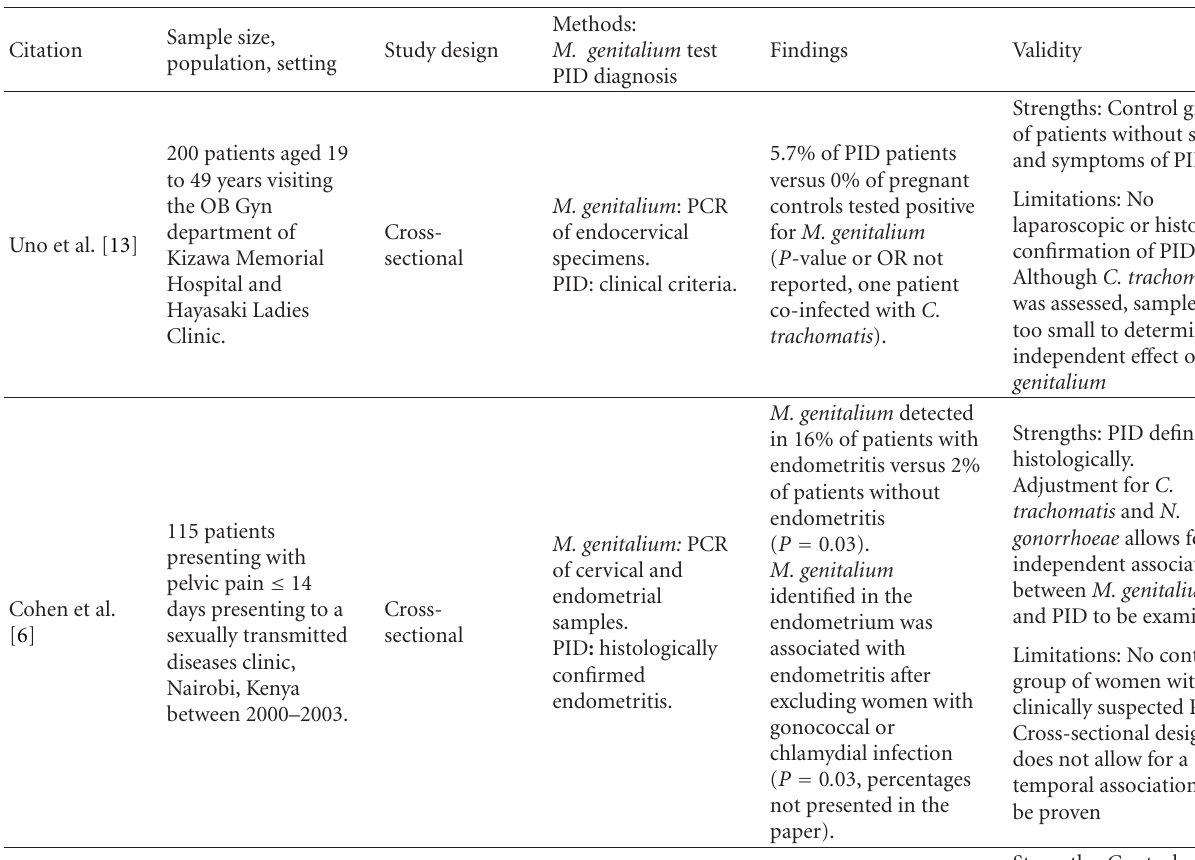
Table 1: Studies evaluating the relationship between M. genitalium and pelvic inflammatory